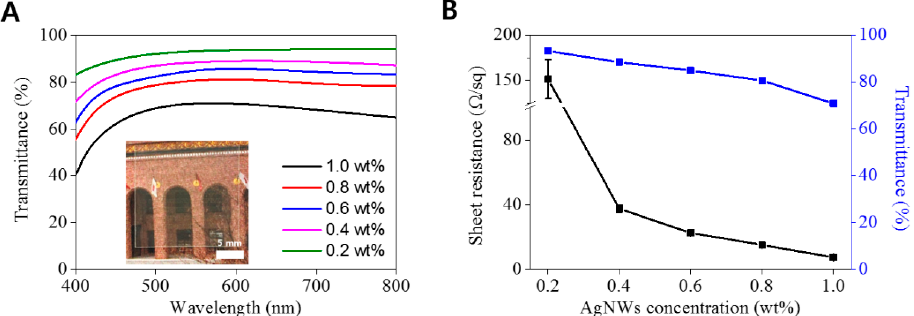
Figure 3. ( A ) Optical transmittance of AgNW-PEG layer on PET films prepared using various concentrations of dispersed AgNWs in the precursor solutions. (A inset) Photograph of highly transparent AgNW-PEG line patterns of line width 1 mm on PET film (AgNW concentration: 0.6 wt %). ( B ) Sheet resistance and transmittance at 550 nm of AgNW-PEG on PET film, versus AgNW concentration of the precursor used.